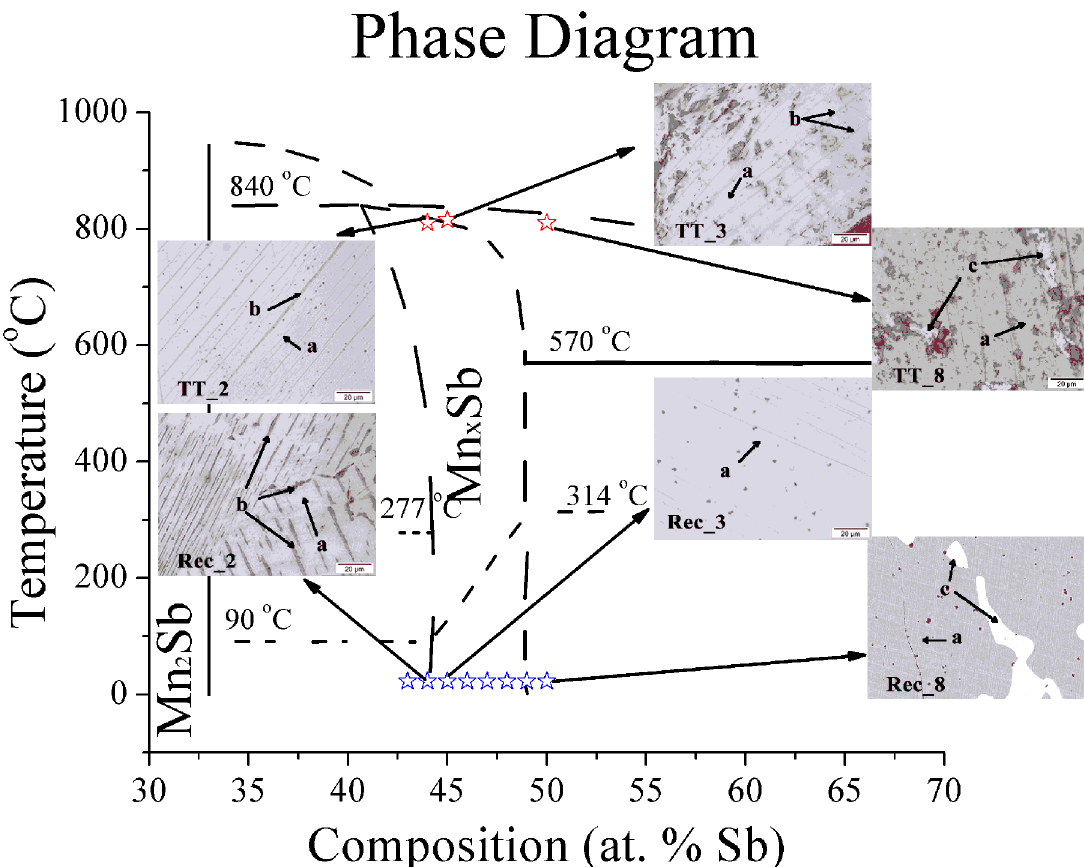
Sb phase, "b" = Mn Sb x 2